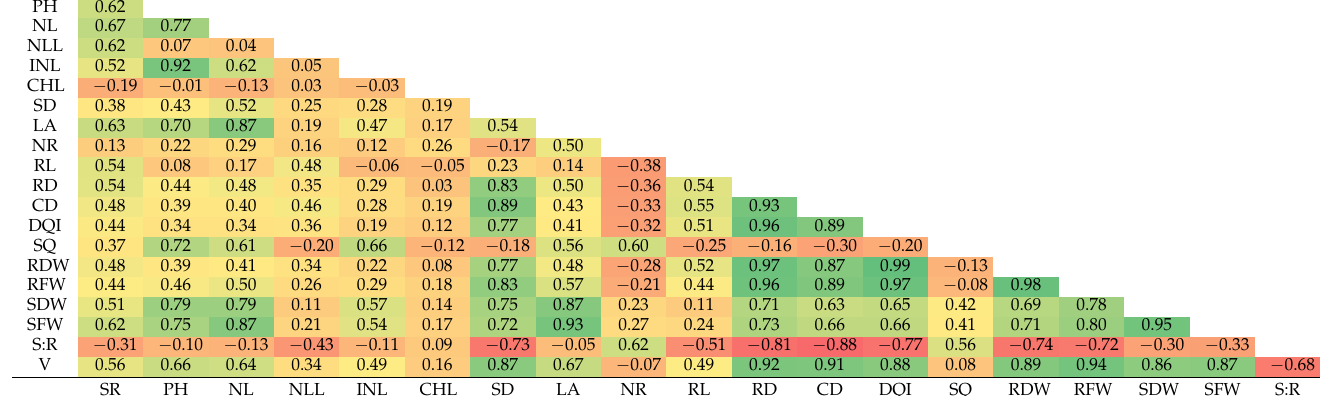
Table 4. Correlation between morphological characteristics and quality of in vitro raised Melia volkensii plants. The background color indicates strong or weak correlation